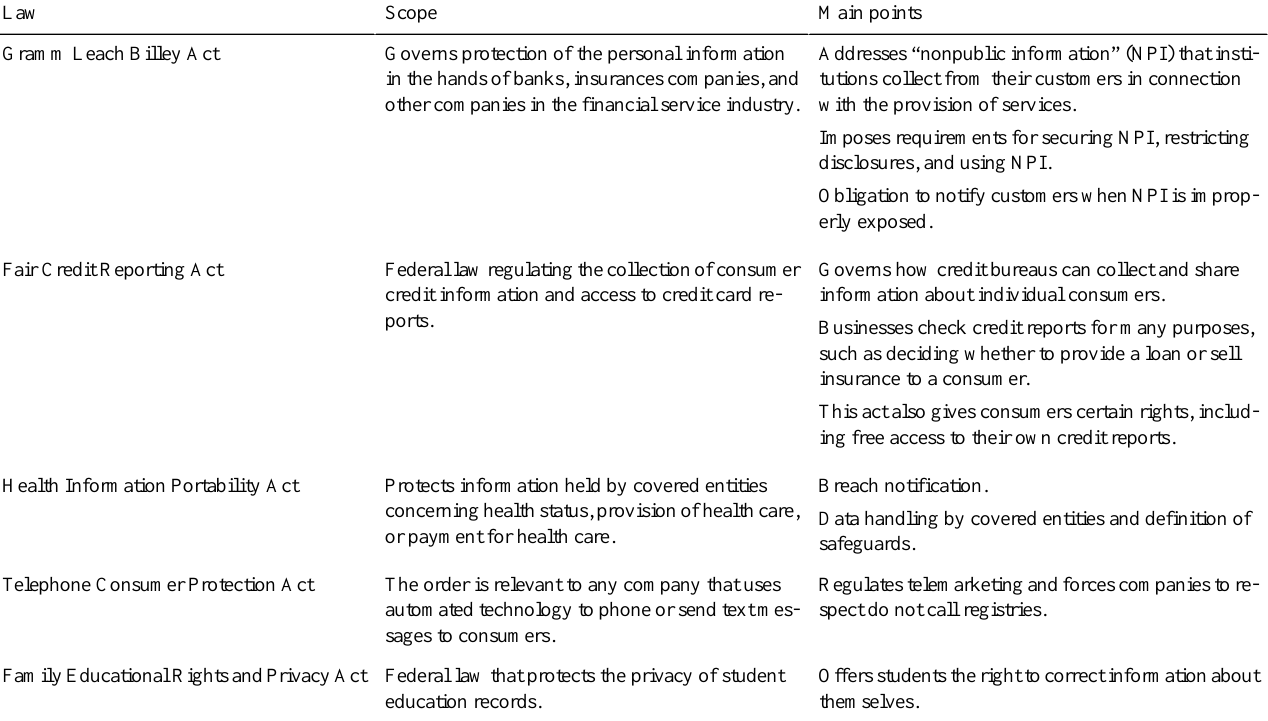
Table 1. Overview of the most important federal laws on data protection in the United States.